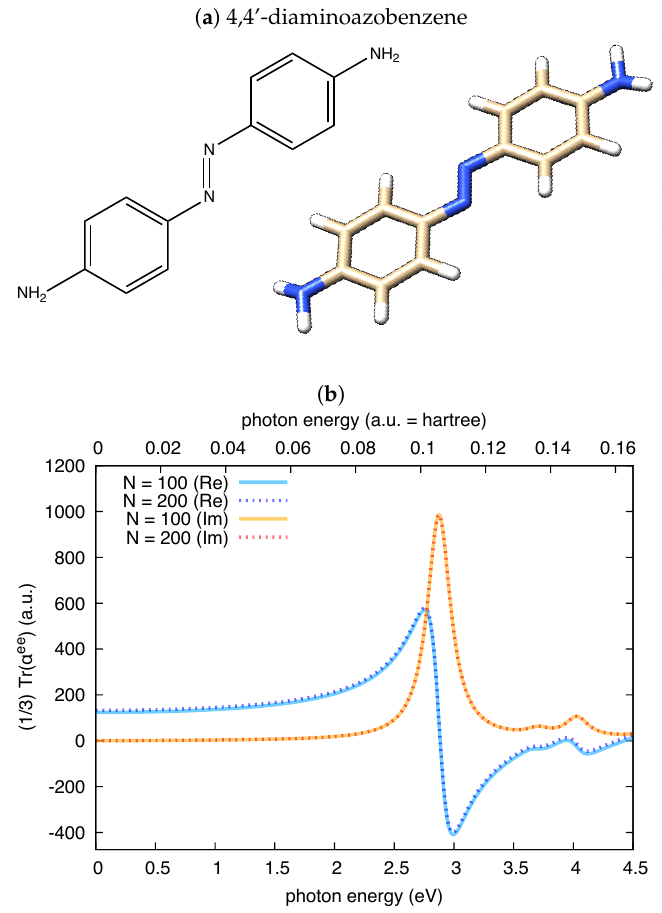
Figure 2. The real and imaginary parts of the isotropic invariant of the electric dipole polarizability of Tr ( α ee ) ) computed by polar from a TDDFT calculation at PBE/cc-pVTZ 4,4’-diaminoazobenzene ( 1 3 level: ( a ) the chemical structure of 4,4’-diaminoazobenzene and the graphical representation of the computed equilibrium structure, which is essentially planar, with the -NH 2 groups slightly pyramidalized; and ( b ) the results obtained by the polar code for two choices of N , demonstrating good convergence at N = 100 states in this photon energy range. To approach the conditions used in [54], the damping Γ for polar calculations is to 0.24